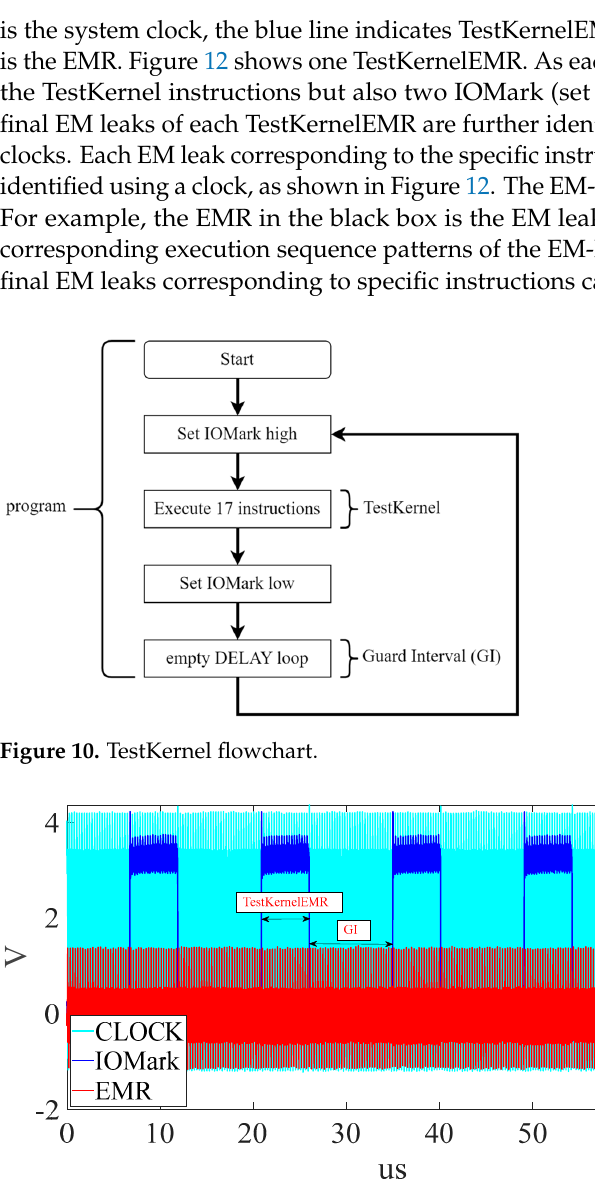
Figure 11. The measurement of the proposed platform.